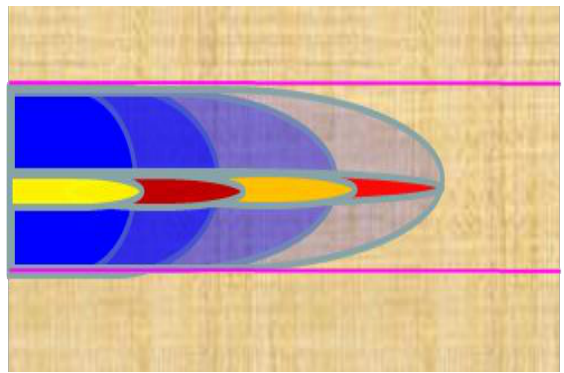
Figure 3. Schematic diagram of fracture propagation and fracturing fluid filtration during fracture flooding.